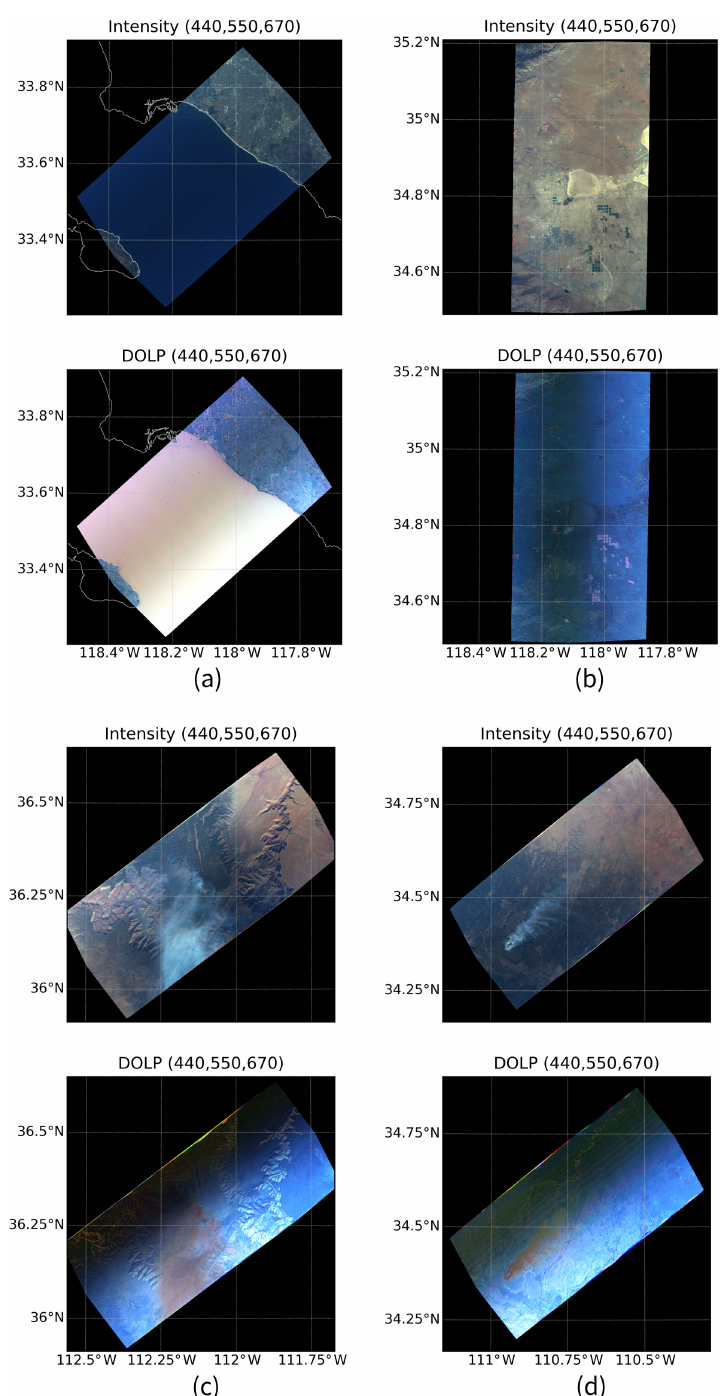
Figure 4. Nadir RGB (670, 550, and 440nm) images of radiance and DoLP for the selected cases from AirHARP flight legs listed in Table 2. The X axis is the longitude and the Y axis the latitude. The scenes include (a) sunglint scene over the Pacific Ocean near Los Angeles, California, USA (23 October 2017 T21:30UTC); (b) Rosamond Dry Lake in California, USA (25 October 2017 T18:26UTC); (c) biomass burning scene near the Kaibab National Forest and Grand Canyon National Park (27 October 2017 T18:16UTC); and (d) biomass burning scene near the Kaibab National Forest (9 November 2017